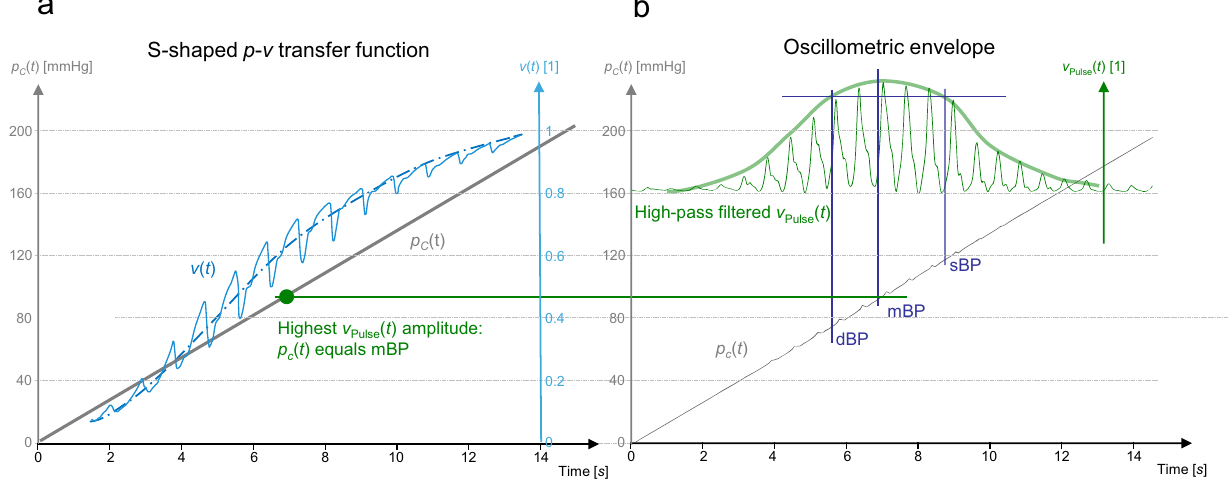
Fig. 3 Depiction of a typical oscillometric curve including its envelope. a The resulting v ( t ) (solid blue line) when a pressure ramp p c ( t ) is applied (ideal pressure ramp shown as the gray line). Averaged signal (dashed-dotted line). The green dot indicates the pressure where the light pulsations are highest. b Amplitudes of v Pulse ( t ) (thin solid line) are fi tted using a Gaussian-style envelope curve (thick solid line). Systolic (sBP), diastolic (dBP), and mean blood pressure (mBP) can be derived from those curves. The gray line shows the measured pressure signal p c ( t of the setpoint p n . Vasodilation shifts the S-curve in the opposite way and VCT decreases p n .